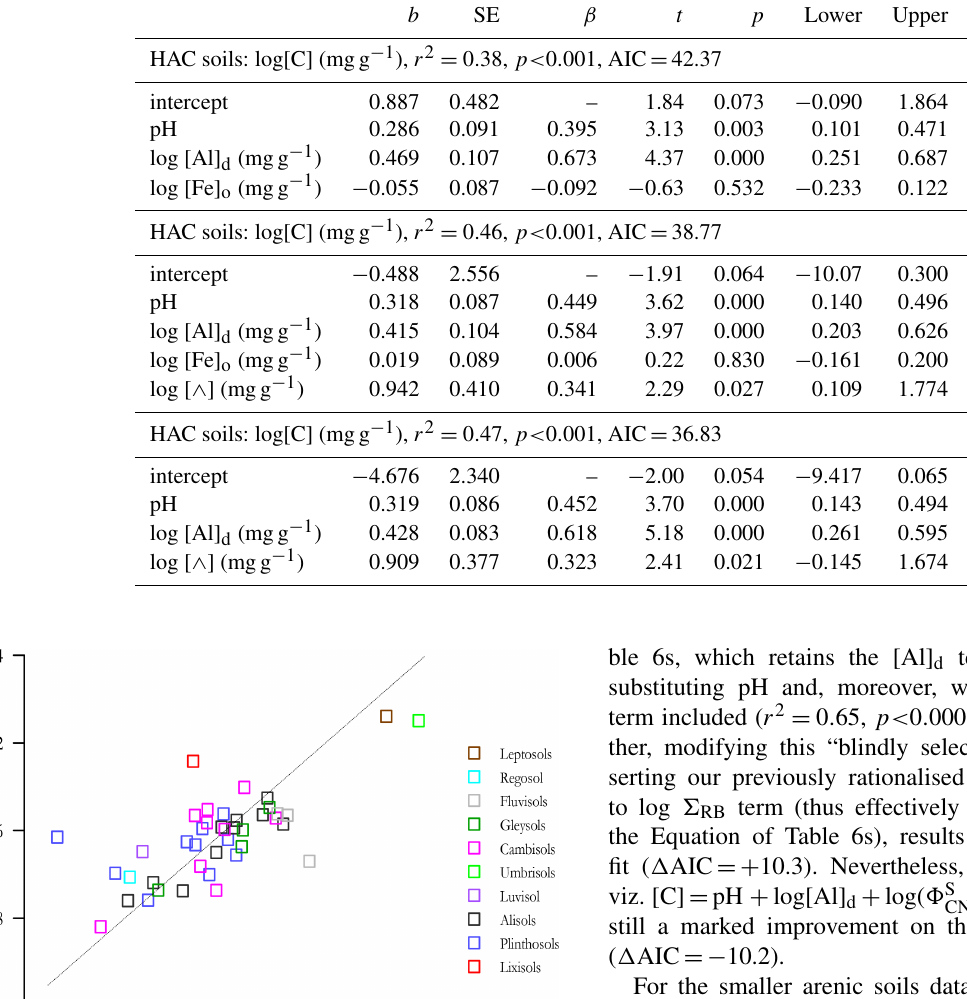
Table 7. Summary of coefficients from OLS regression models for HAC soils. Interactions of soil organic carbon, soil pH, leaf litter lignin content ( ∧ ) and dithionite extractable Al.